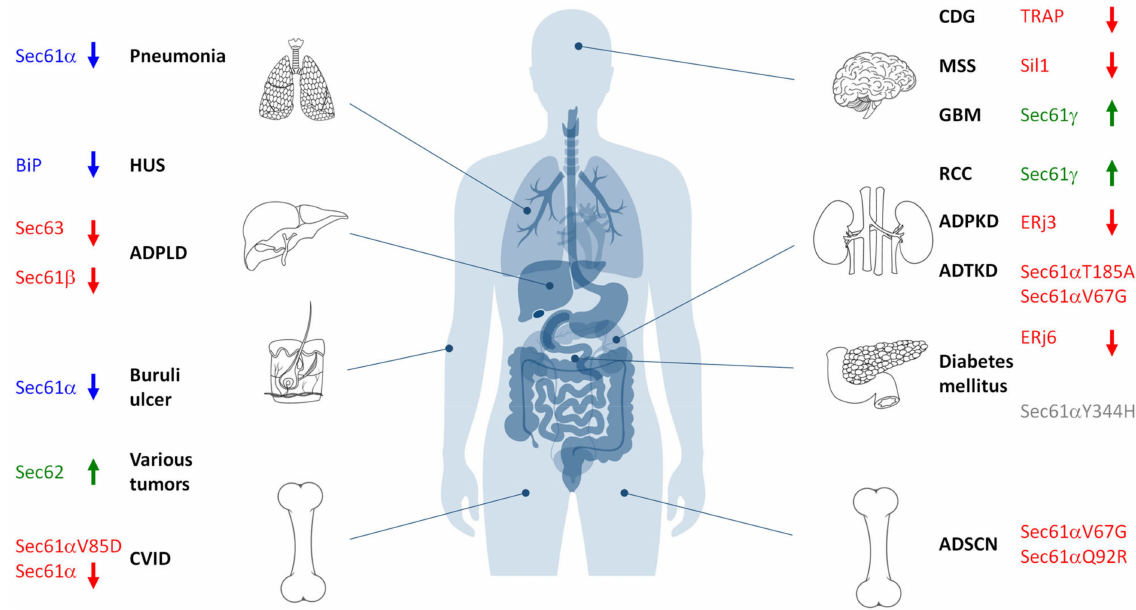
Figure 6. Hereditary and acquired diseases that are linked to the Sec61 complex and its allosteric effectors. The figure highlights various disease phenotypes, which are discussed in the text. Proteins affected in human hereditary diseases are indicated in red, protein targets of toxin-determined human diseases in blue, over-produced proteins in human tumor diseases in green (see below) and a genetically-determined variant causing murine Diabetes mellitus in grey. The arrows point upwards for increased activity of the indicated component and downwards for decreased activity. ADPKD, autosomal dominant polycystic kidney disease; ADPLD, autosomal dominant polycystic liver disease; ADSCN, autosomal dominant severe congenital neutropenia; ADTKD, autosomal dominant tubulo-interstitial kidney disease; CDG, congenital disorder of glycosylation; CVID, common variable immunodeficiency; GBM, glioblastoma multiforme; HUS, hemolytic uremic syndrome; MSS, Marinesco–Sjögren syndrome; RCC, renal cell